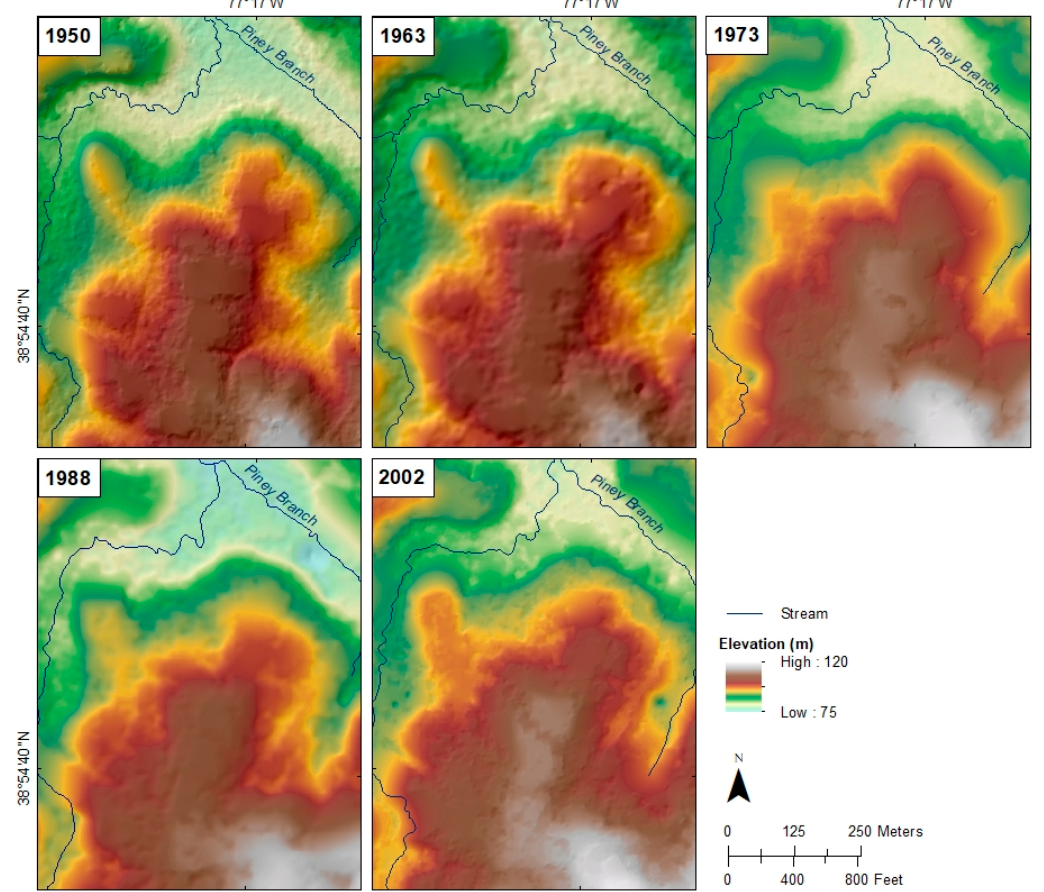
Figure 4. DTMs produced by SfM analysis of historical aerial images and subsequent filtering.